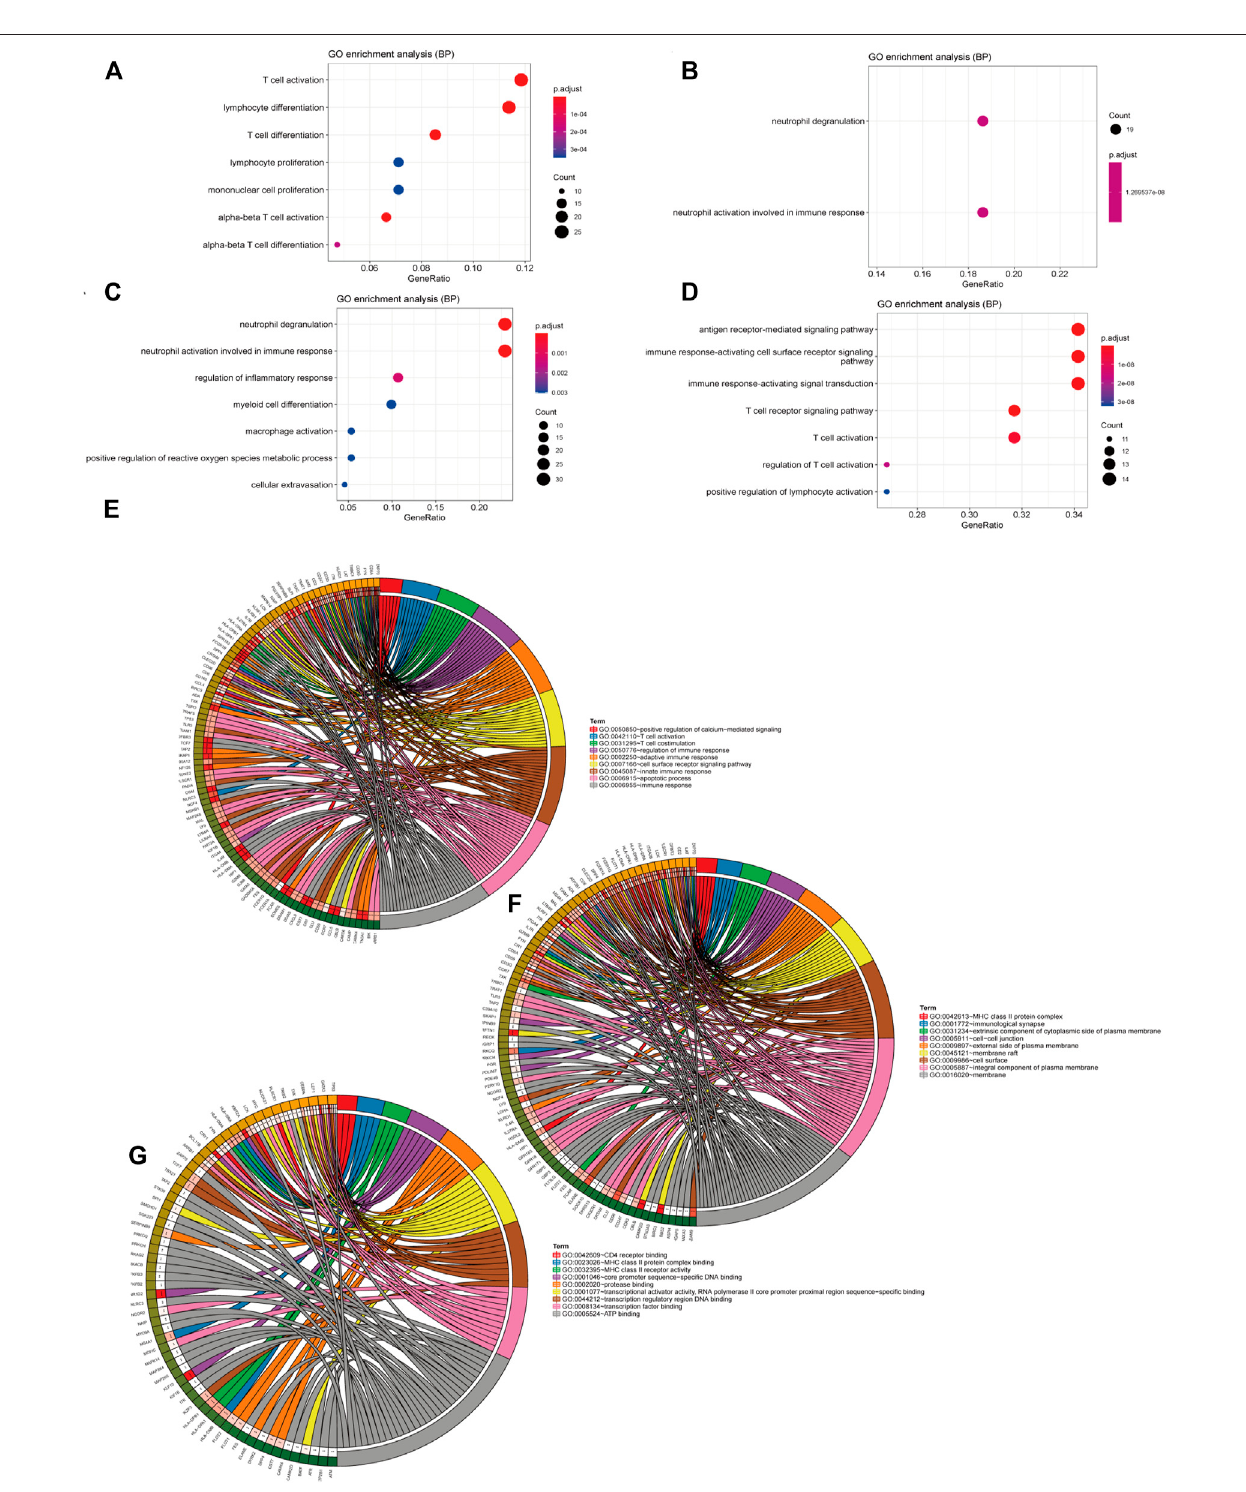
FIGURE5| Resultsoftheenrichmentanalysis. (A – D) Theordinateisthepathway nameandtheabscissaistheproportionofgenesinthepathway.Theredderthe circle, the bigger the p value. (A) Enrichment analysis of genes in the blue module in WGCNA, (B) in green, (C) in turquoise, and (D) in yellow. (E – G) Results of the enrichment analysis with 210 immune-related genes that we got from the pathway in the enrichment analysis in the four gene modules.